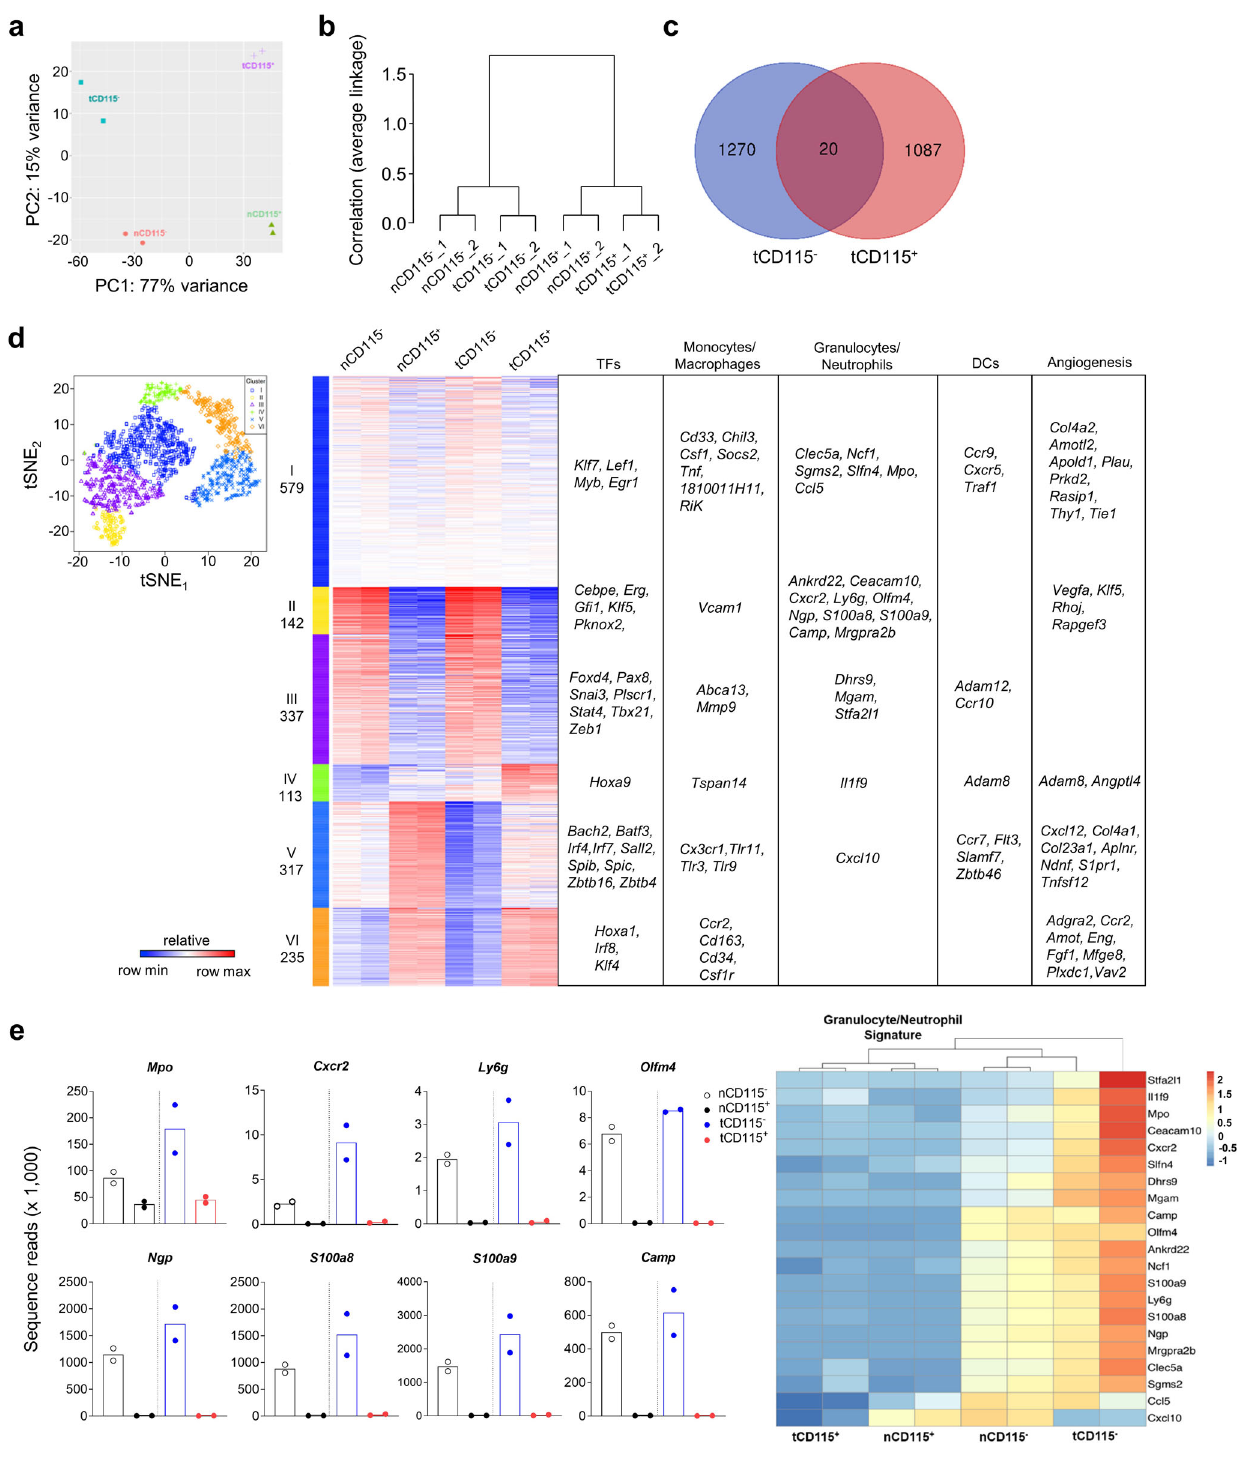
Fig. 3 Granulocyte/neutrophil-related gene expression in CD115 − monocytic cells. CD115 − and CD115 + monocytic cells were sorted from BM of naive or EL4 TB mice. Total RNA was extracted and subjected to transcriptome analysis. Data shown are from two biological replicates of each group. The letter “ n ” and “ t ” in front of CD115 indicate that cells were isolated from tumor-free and TB mice, respectively. a Principal component analysis plot. b Hierarchical cluster of four cell types. c Venn diagram shows variation between sorted CD115 − and CD115 + M-MDSC libraries in EL4 TB mice. d t-SNE plot of K-means clusters and lists of representative genes with more than 2-fold changes. DCs, dendritic cells. TFs, transcription factors. e Sequence reads and heatmap of selected granulocyte/neutrophil-associated variable genes (each dot in graph represents different biological replicates).